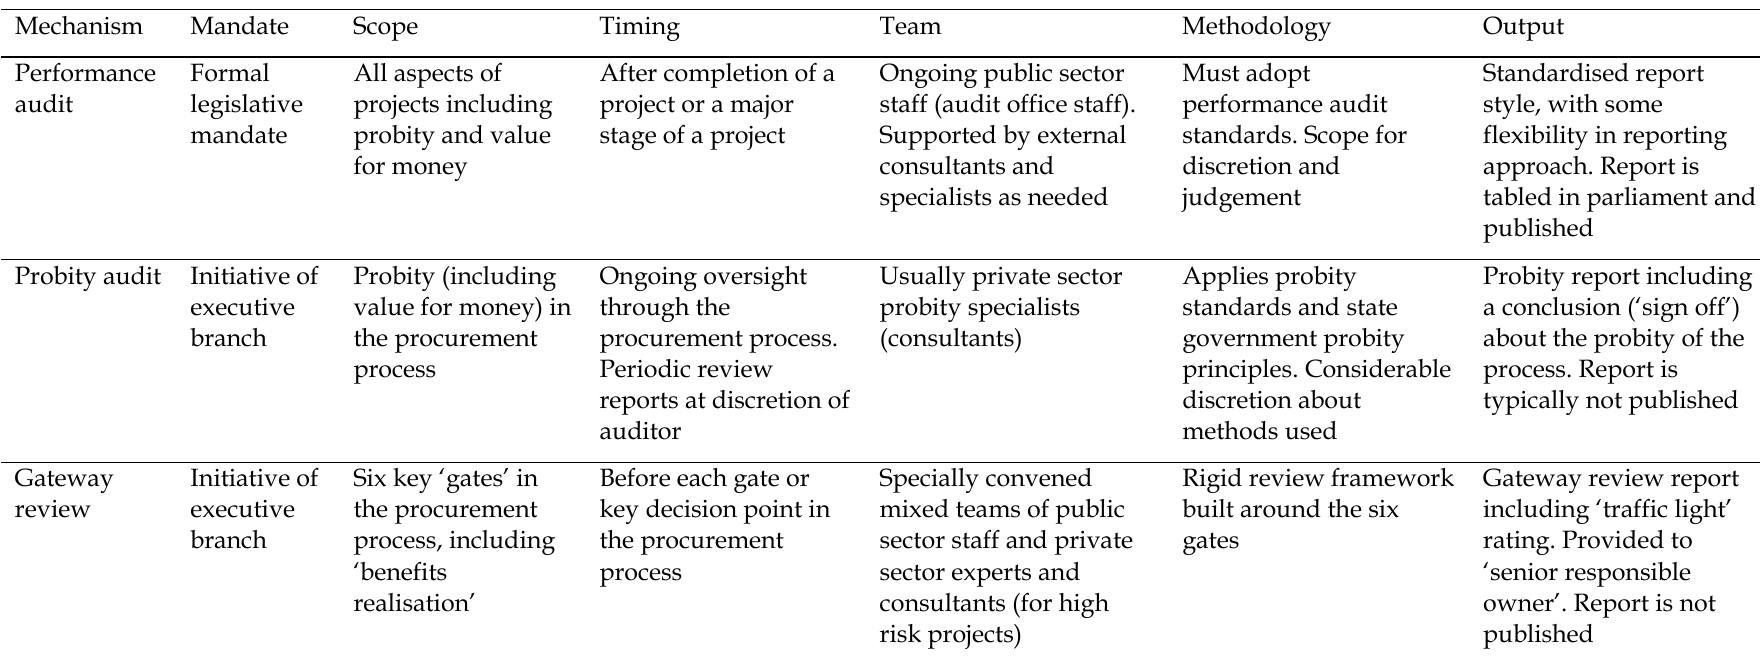
Table 1. Summary of the three independent scrutiny